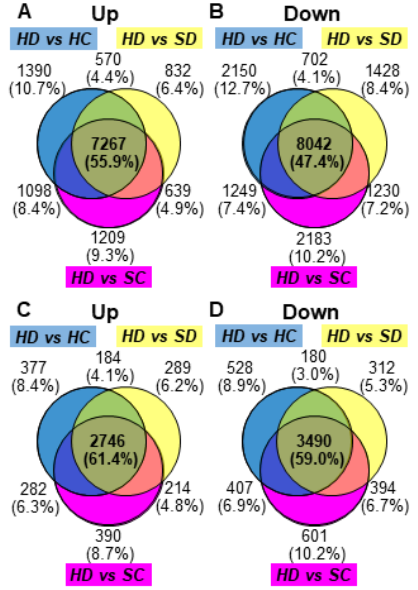
Figure 2. Expression changes of HSP90 family genes in RNA-seq samples. Relative normalized read counts in all RNA-seq samples are shown for tobacco homologs of Arabidopsis HSP90 family genes: ( A ) cytosolic HSP90.1; ( B ) nucleo-cytosolic HSP90.2; ( C ) cytosolic HSP90.4; ( D ) chloroplast HSP90C or HSP90.5; ( E ) mitochondrial HSP90.6; ( F ) ER-localized HSP90.7. Statistical significance of the di ff erence